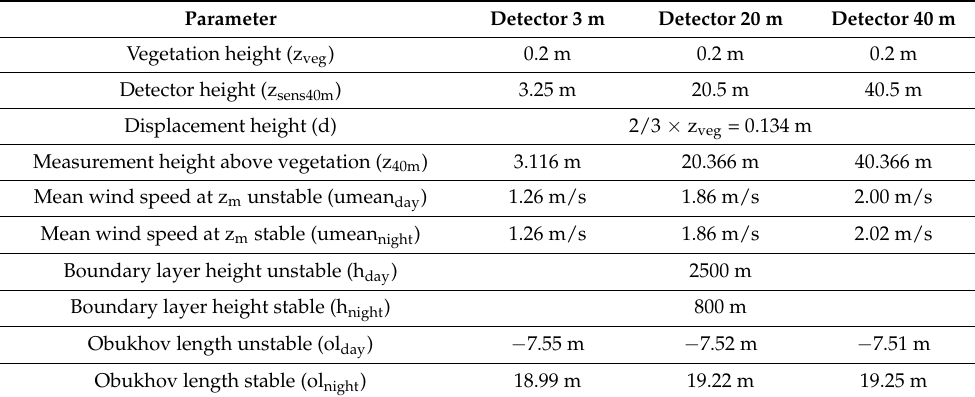
Table 2. Input parameters for running the models FFP and K–M.